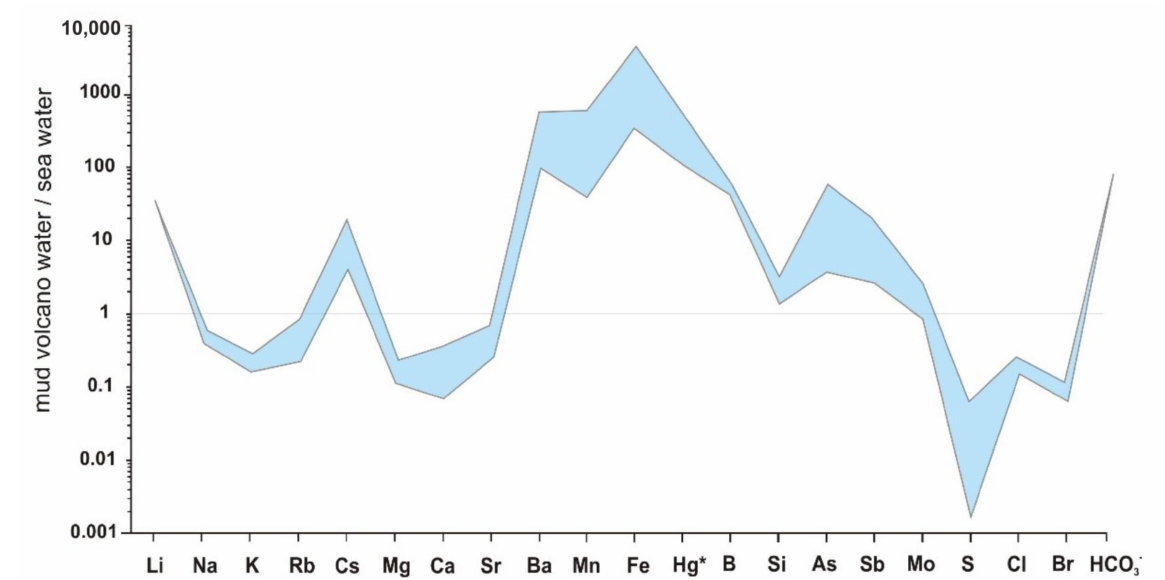
Figure 5. Multi-element seawater-normalized [68] patterns of South Sakhalin MV waters. * Mercury content in seawater according to